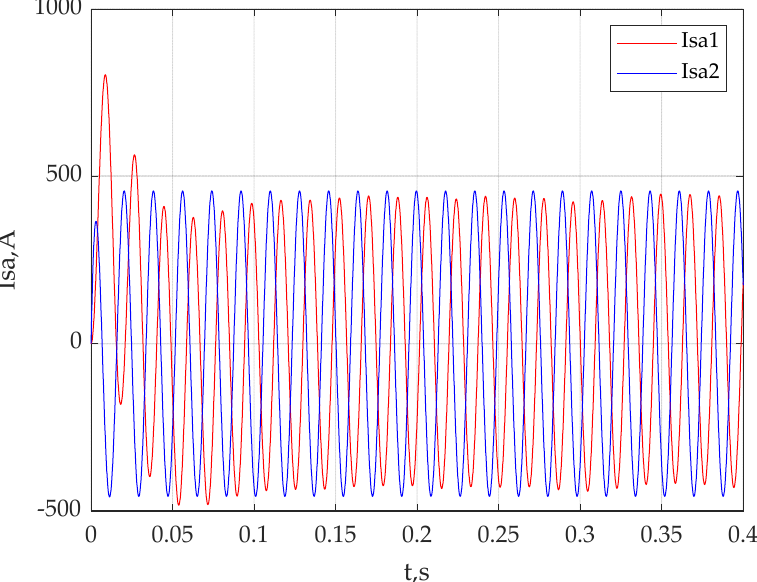
Figure 6. Time diagrams of stator current of phase A of the traction motor: I sa1 —of the basic scheme of vector control; I sa2 —of the control system with the optimal controller.